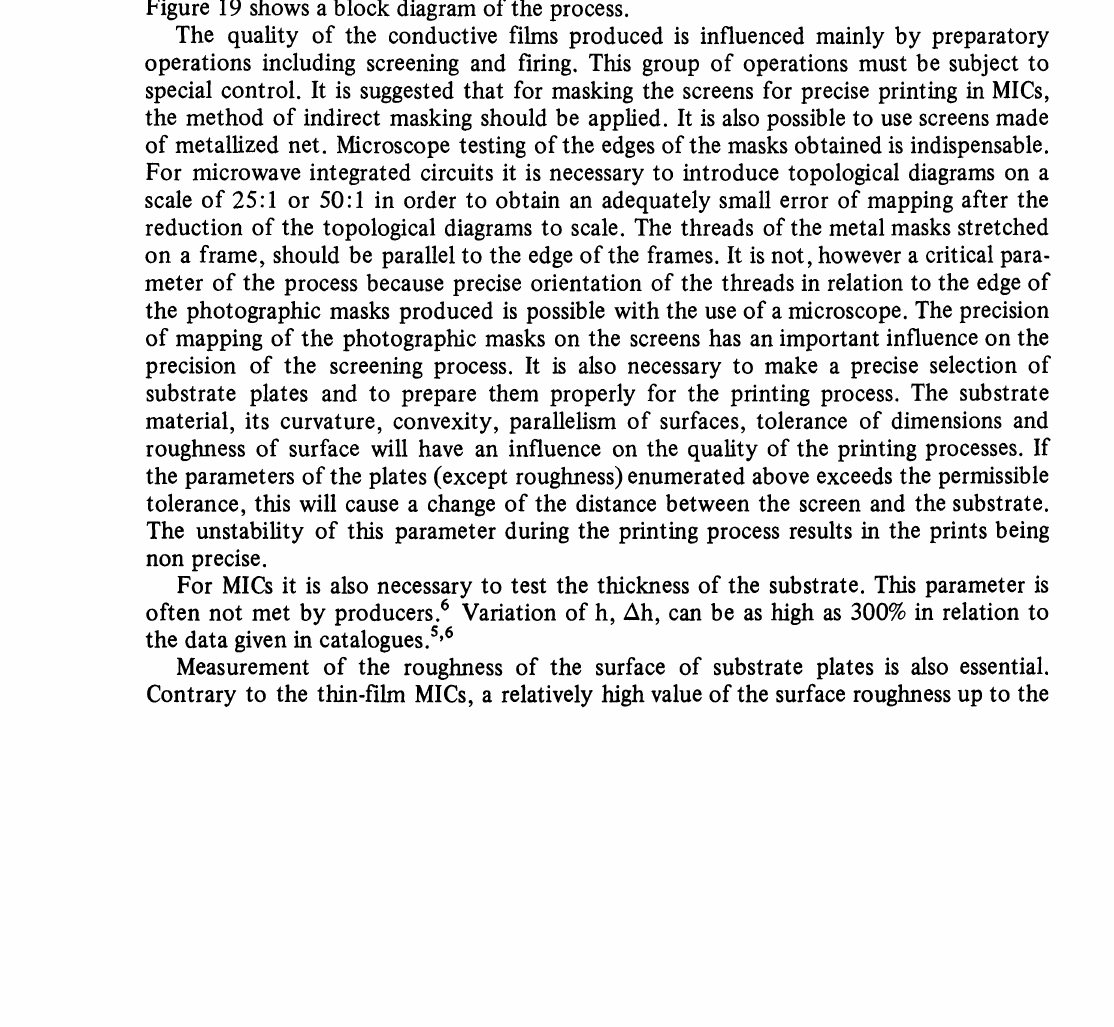
FIGURE 19 Block diagram of proposed technological process for production of thick-film MIC,